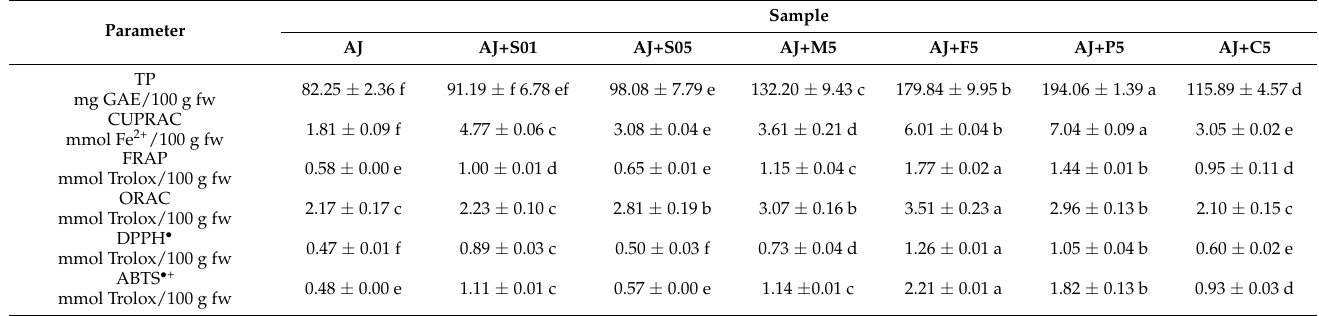
Table 3. Antioxidant activity of analysed apple juice and enriched apple